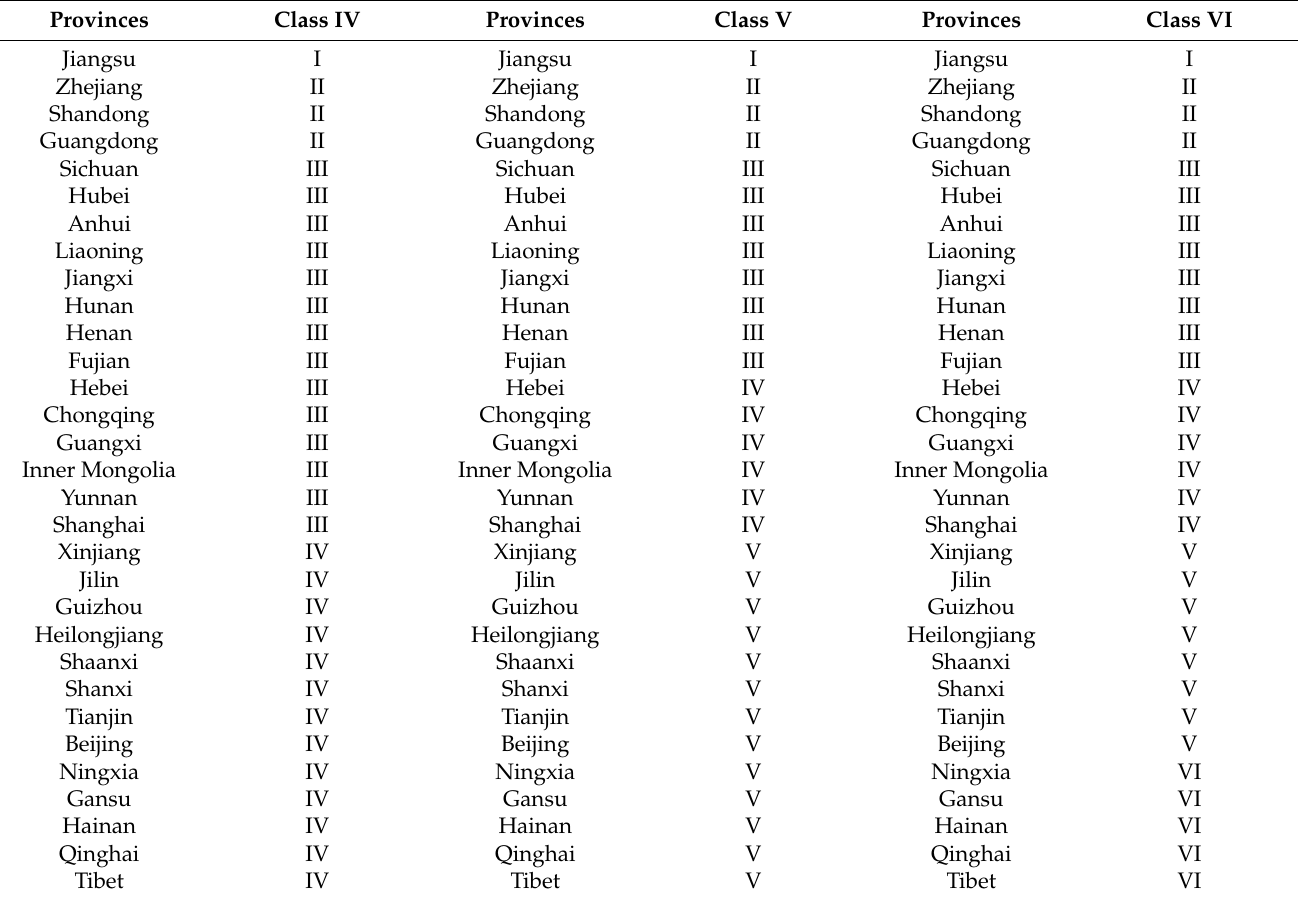
Table 6. Clustering results of land fiscal ecological cost of 31 provinces in 4, 5, and 6